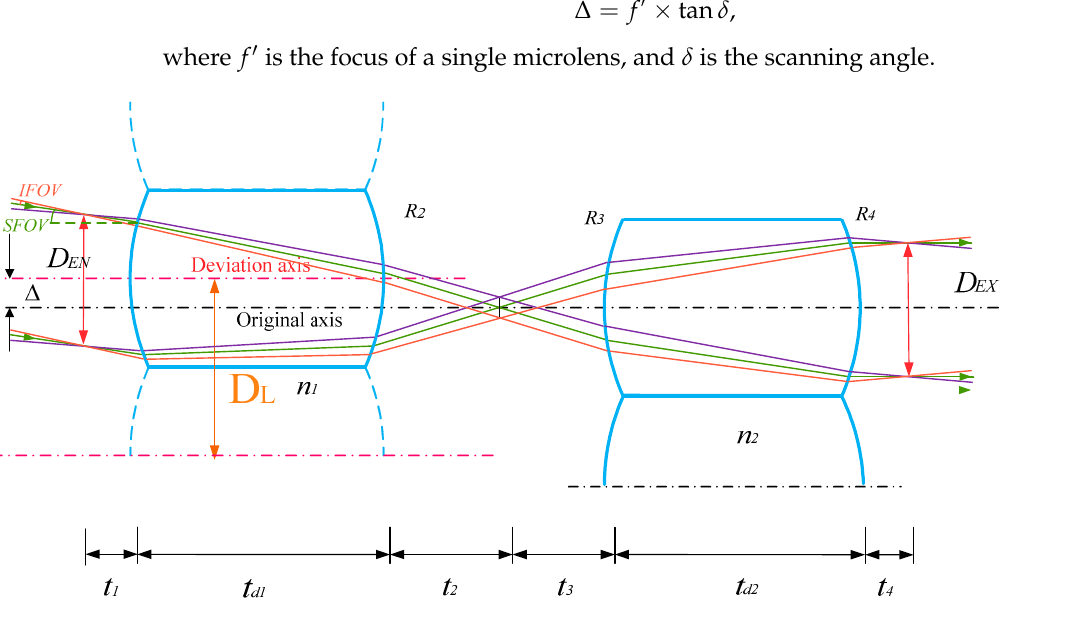
Figure 1. Schematic diagram of the scanning principle of the microlens array (green: SFOV, red: SFOV+IFOV, purple: SFOV-IFOV).